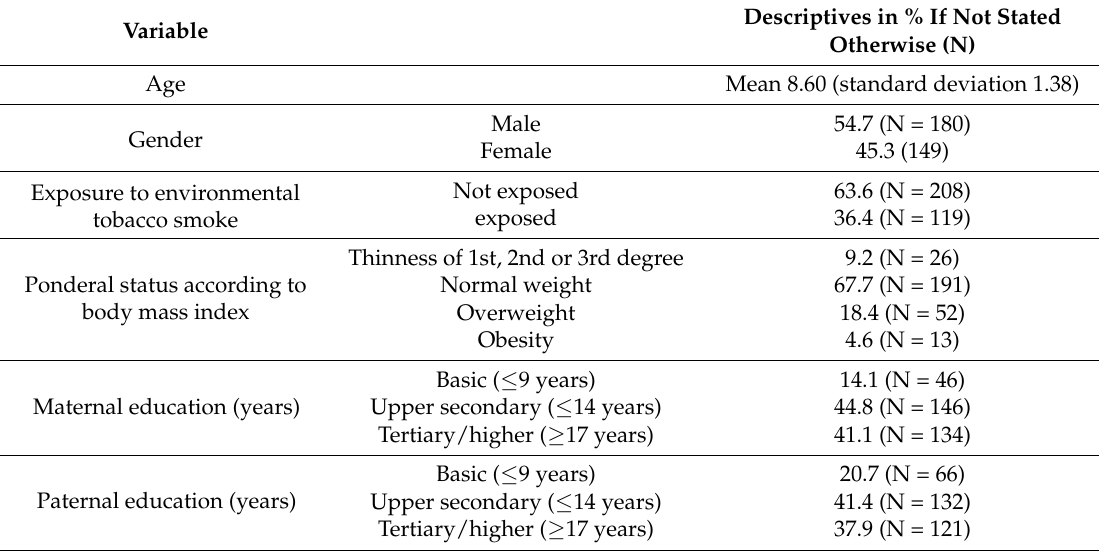
Table 1. Characteristics of the study population.